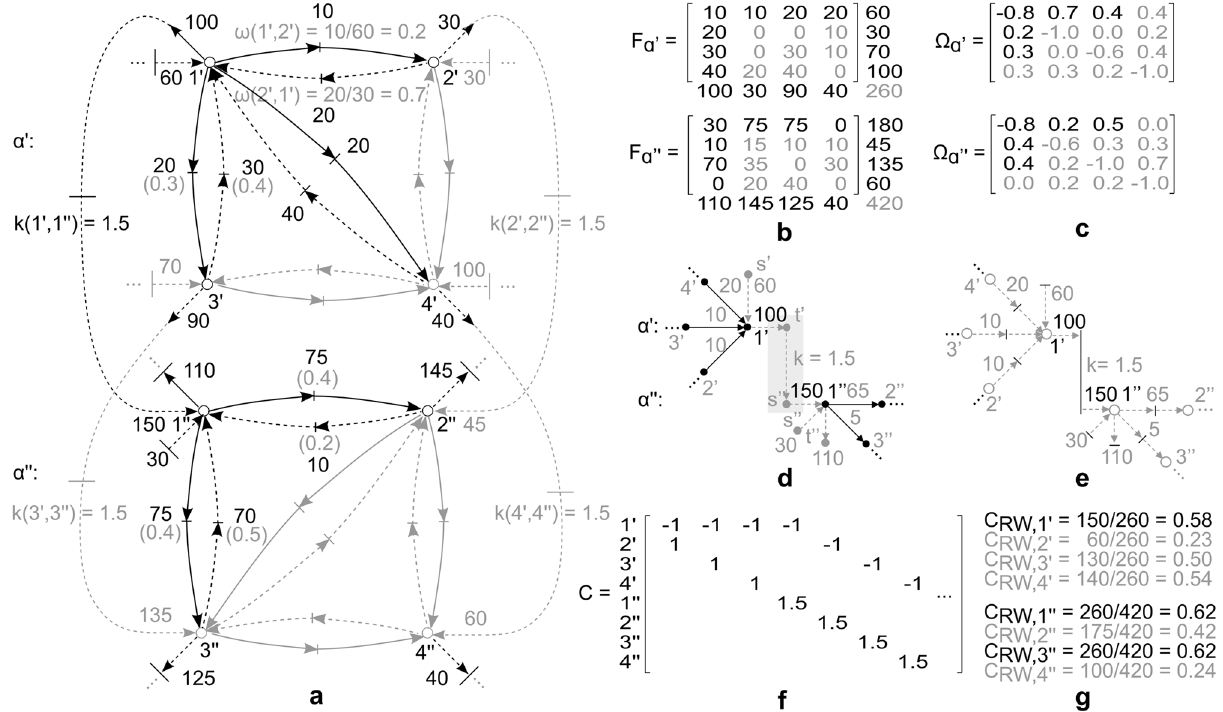
Figure 5. Simplified illustration of multilayer flow network (proxy), equivalent to the dataset of U.S. GDP by industry 54 . ( a ) Illustrative multilayer flow network interpretation, corresponding to dataset 54 . Nodes correspond to industries, while arcs and links correspond to economic activity (cross-industry and cross-layer network flow). Conversion coefficient k refers to a proportion defined with respect to e.g., rate of return, where layers α ′ , α ′′ correspond to years (note that the network could be represented in compact form as well). Rate of transfer arc weights ω are derived from supply and cross-industry network flow. Note that a node (e.g., node { 1 ′ } ), participates in domestic output and supply of commodities required by other industries (expressed in monetary terms), where total supply relates to node potential. The generated output participates, furthermore, in value added and capital carried over to the next time instance (i.e., node { 1 ′′ } ). ( b ) Illustration of cross-industry network flow matrix F , corresponding to dataset 54 (as derived from the corresponding manual “Concepts and Methods of the U.S. Input-Output Accounts”, 2009 54 ). The dataset consists of domestic supply (rows) and use (columns) of commodities by industry (intermediate use of commodities, net of contributions and subsidies). Note that 53 relates total use, as opposed to total supply, to node potentials. ( c ) Compartmental weight matrix (cid:31) , derived from rate of transfer arc weights ω . Note that (cid:31) r i , u i = r i ω( u i , r i ) = 1 (see weight matrix (cid:31) diagonal)